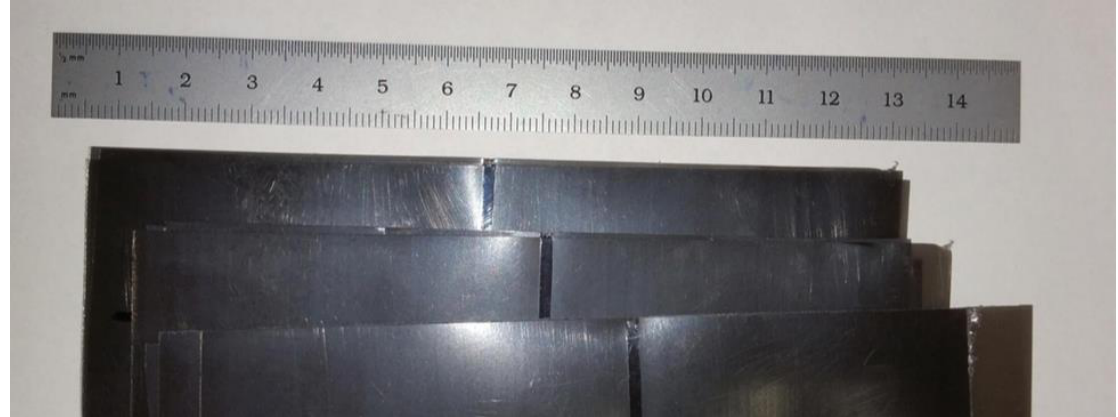
Figure 4. Representative weld width analysis photograph.